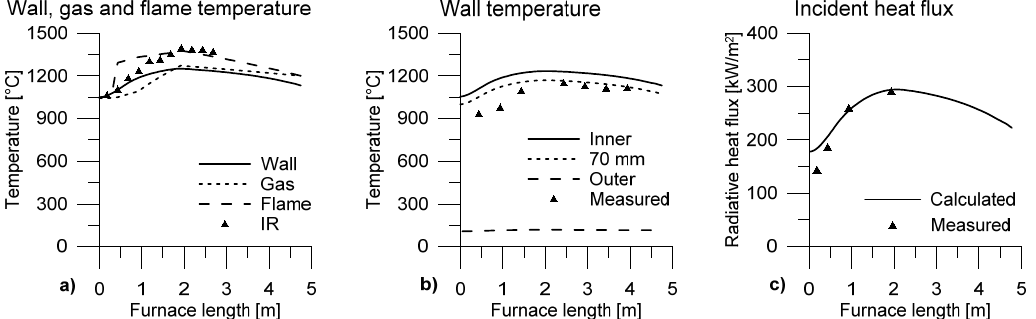
Figure 7. Measured (triangles) and modelled temperatures at the ( a ) inner wall, ( b ) inner, intermediate position at 70 mm from the inner surface of the wall and outer wall. ( c ) Measured (triangles) and modelled incident radiative heat flux at inner wall.